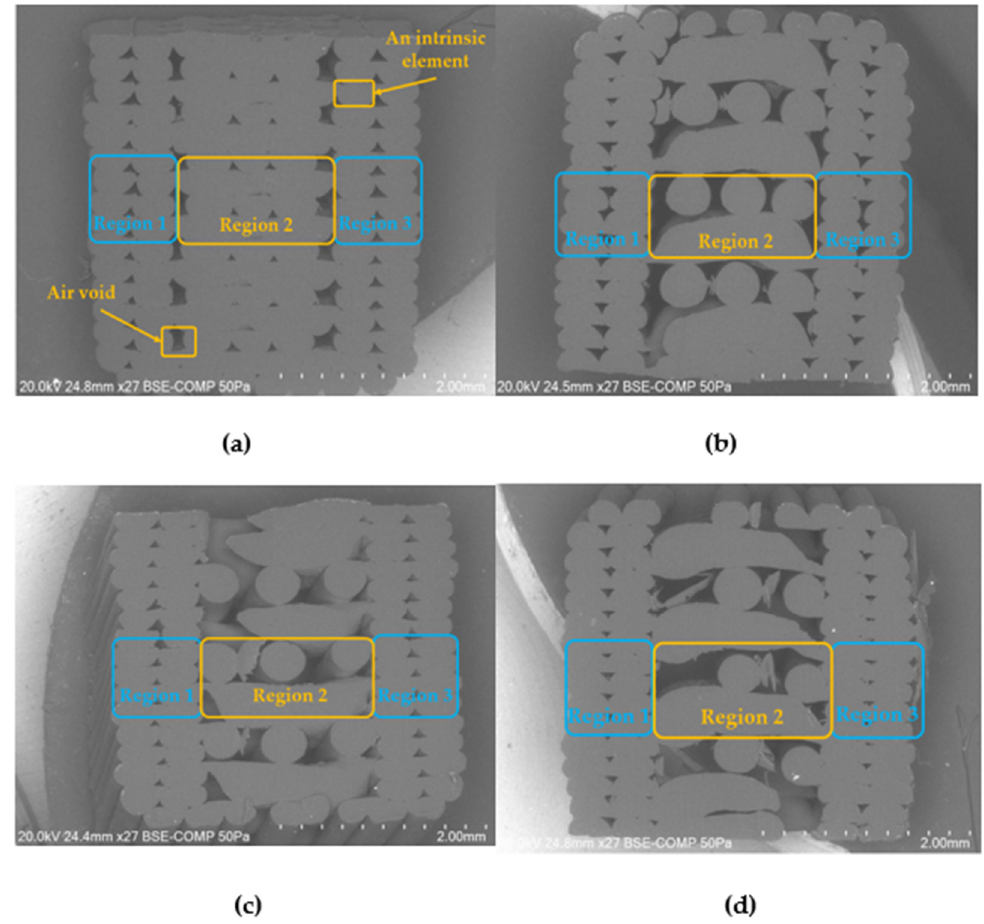
Figure 3. SEM image of ABS at ( a ) 100%, ( b ) 80%, ( c ) 60%, ( d ) and 40% infill density and longitudinal orientation.